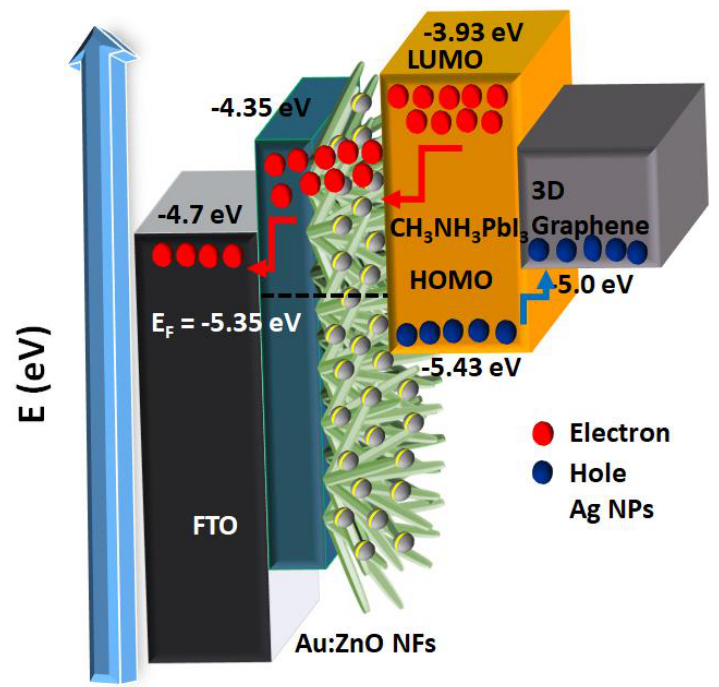
Figure 9. Electron-hole separation and transportation mechanism of plasmonic Ag NPs integrated Figure 9. Electron − hole separation and transportation mechanism of plasmonic Ag NPs integrated within ZnO within ZnO NFs.